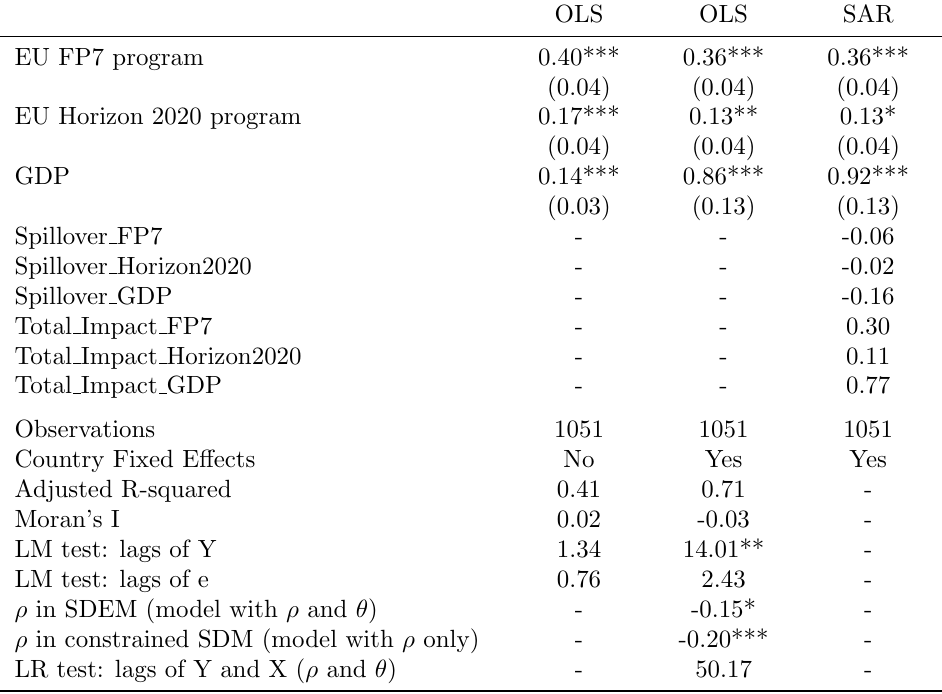
Table 3: Estimates of (Spatial) Knowledge Production Function by scientific publications per capita, considering funding from EU FP7 and EU Horizon 2020 program as innovatory effort – Inputs and outputs per capita (log-scale incl.